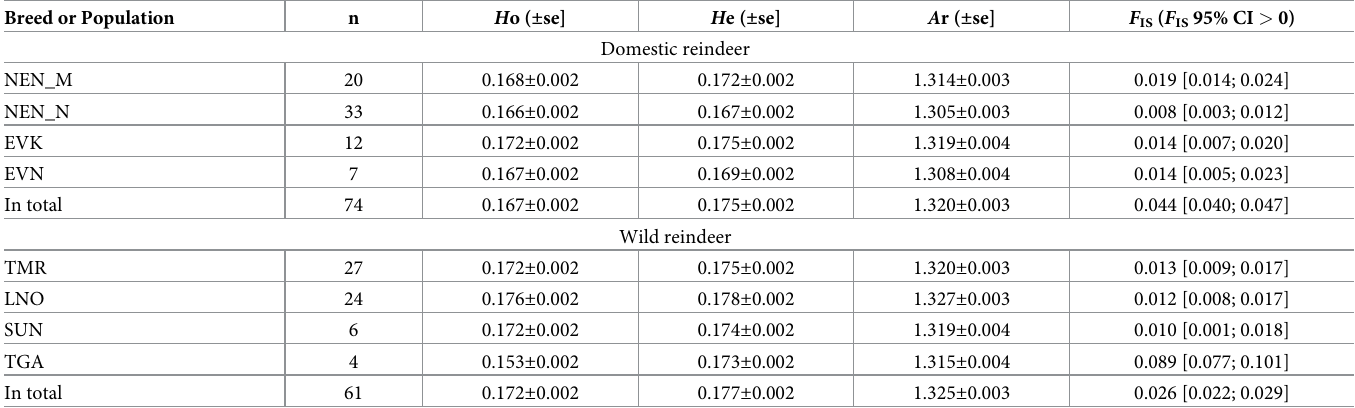
Table 1. Parameters of genetic diversity of domestic and wild reindeer populations based on 8357 SNPs. Breed or